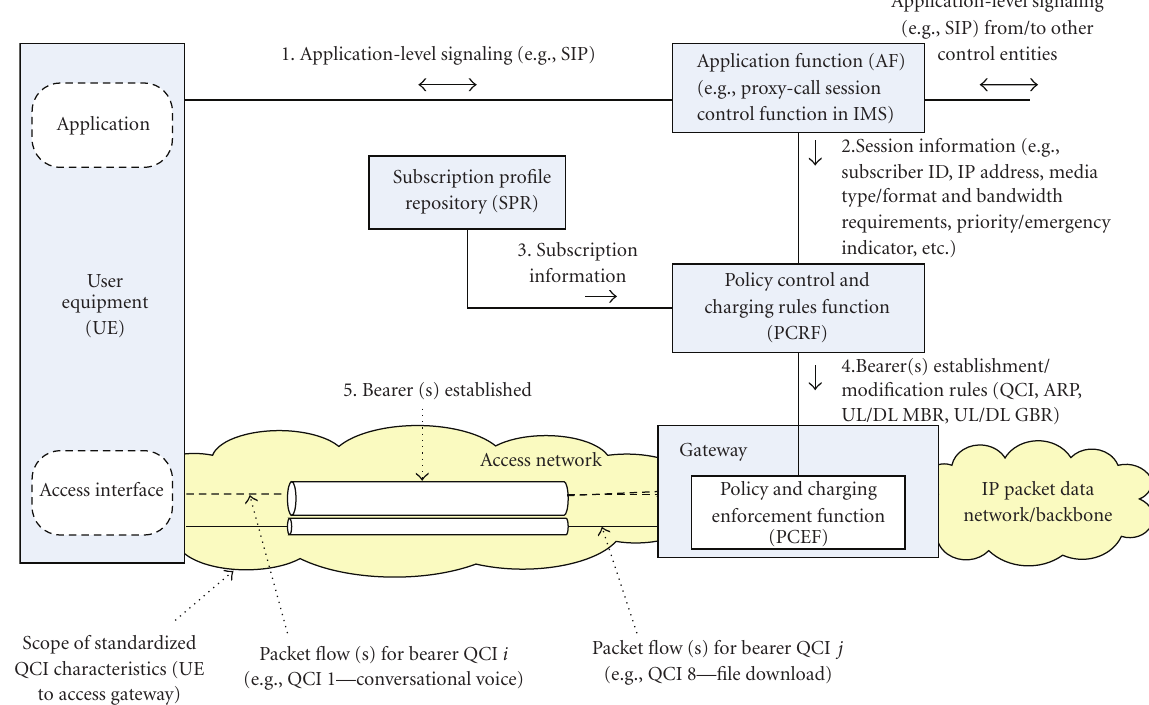
Figure 2: QoS control in 3GPP EPS policy and charging control